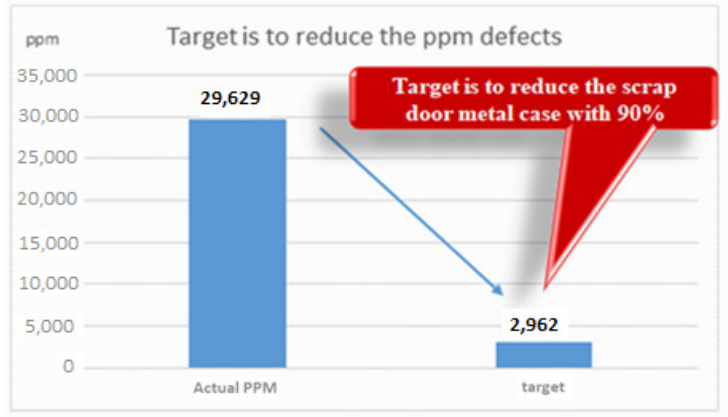
Figure 8. Identification of the target. Figure 8. Identi fi cation of the target. Figure 8. Identi fi cation of the target.